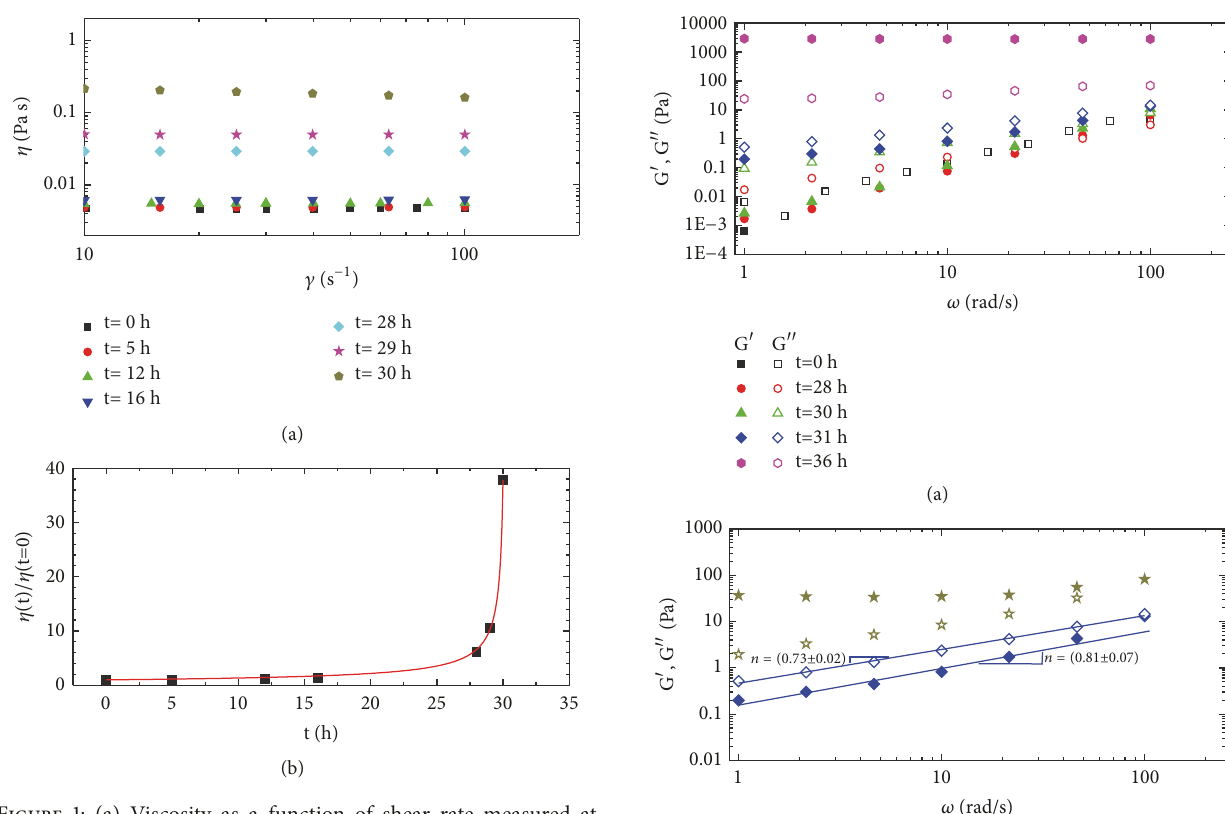
Figure 1: (a) Viscosity as a function of shear rate measured at different times after sample preparation at T=25 ∘ C: black squares (t = 0 h), red circles (t = 5 h), green up triangles (t = 12 h), blue down triangles(t=16h),cyandiamonds(t=28h),pinkstars(t=29h),and dark yellow pentagon (t = 30 h). (b) Normalized viscosity measured as a function of time (squares) and power law fit, (1 − (𝑡/𝑡 𝑔𝑒𝑙 )) −𝑠 , Figure 2: (a) Elastic (solid symbols) and viscous (hollow symbols) to the experimental data, where t and s are fitting parameters moduli measured as a function of frequency at different reaction gel (continuous line). times at T=25 ∘ C: immediately after sample preparation (black squares), after 28 hours (red circles), after 30 hours (green triangles), and after 36 hours (pink hexagons). (b) Elastic and viscous moduli measured 31 hours after sample preparation (blue diamonds) along their corresponding fits to a power law G ∼ 𝜔 n (continuous lines) and 32 hours after sample preparation (dark yellow